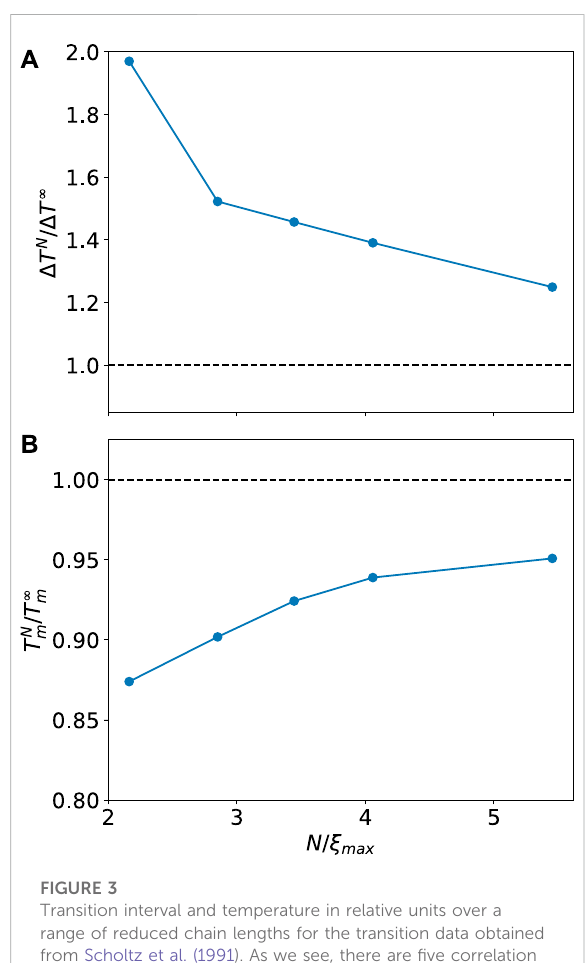
FIGURE 3 Transition interval and temperature in relative units over a range of reduced chain lengths for the transition data obtained from Scholtz et al. (1991). As we see, there are fi ve correlation lengths and the fi nite size effects are still